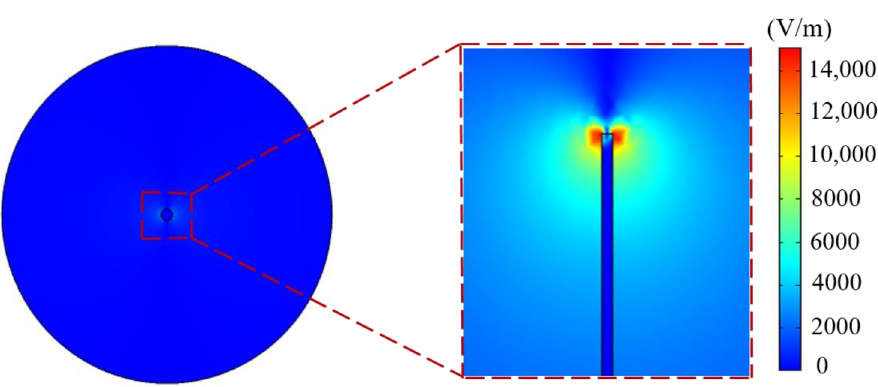
Figure 8. Electric field simulation performed on the cross-section of the copper tube using copper oxide modified